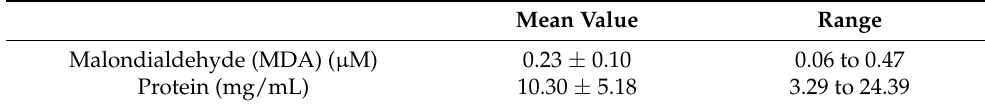
Table 2. Concentration in subretinal fluid.